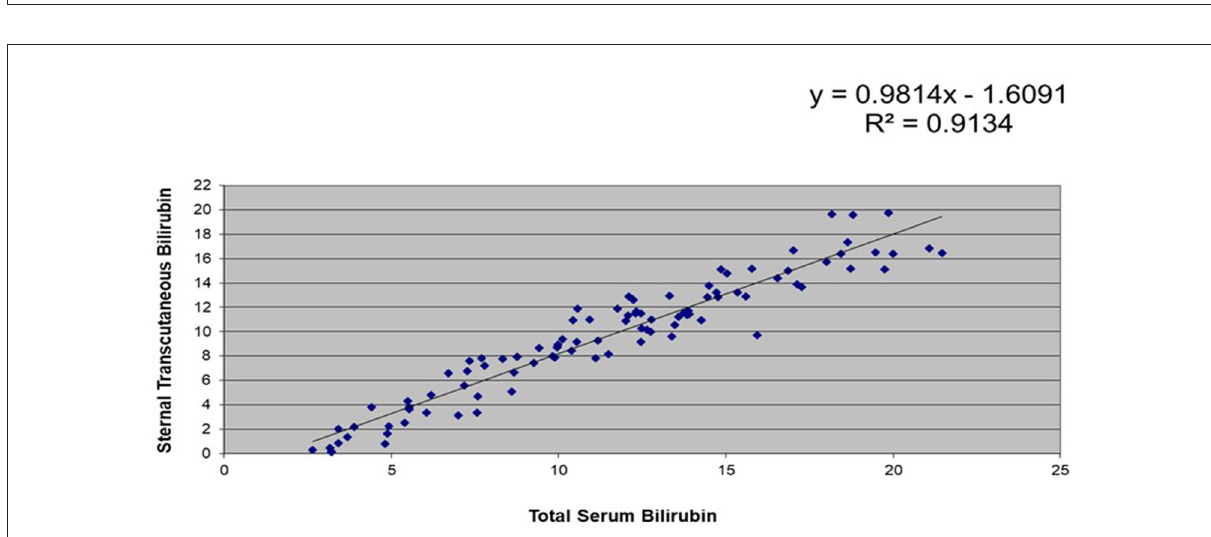
FIGURE2 Correlation between total serum bilirubin (TsB) and sternal transcutaneous bilirubin (TcB) levels among stable, full-term Filipino infants ( n = 106).